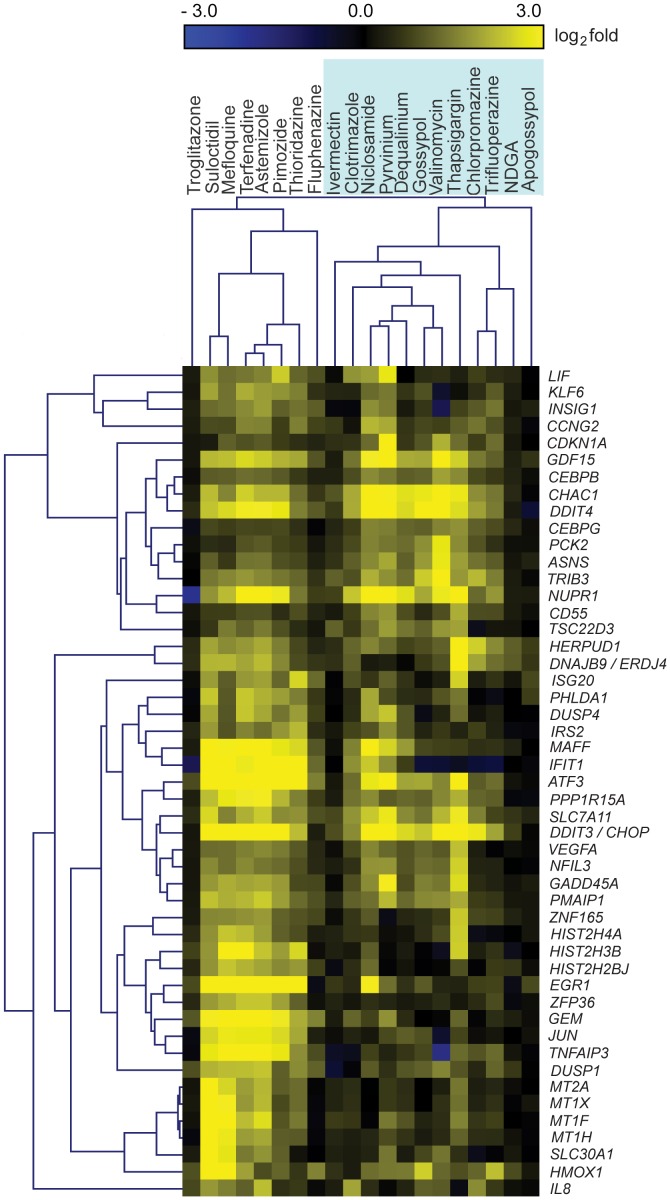
Hierarchical clustering reveals a possible role for Ca2+ homeostasis in ER membrane reorganization.Heat map analysis comparing the top 50 differentially expressed genes following the indicated drug treatments as available in the connectivity map reference database. Yellow and blue indicate up or down regulation, respectively. Hierarchical clustering was used to analyze microarray data for chemicals known to induce ER membrane reorganization. The microarray data were normalized, compared with the equivalent control samples, and filtered by mean channel intensity (<250) and mean log2 fold changes across all the data sets (<1.8). Trends in the resulting gene expression matrix were analyzed, using a Pearson correlation metric and average link clustering. Based on transcriptional trends, two distinct groups of chemicals were identified. Apogossypol clustered with a number of chemicals that are known to disrupt Ca2+ homeostasis (shaded in blue box).